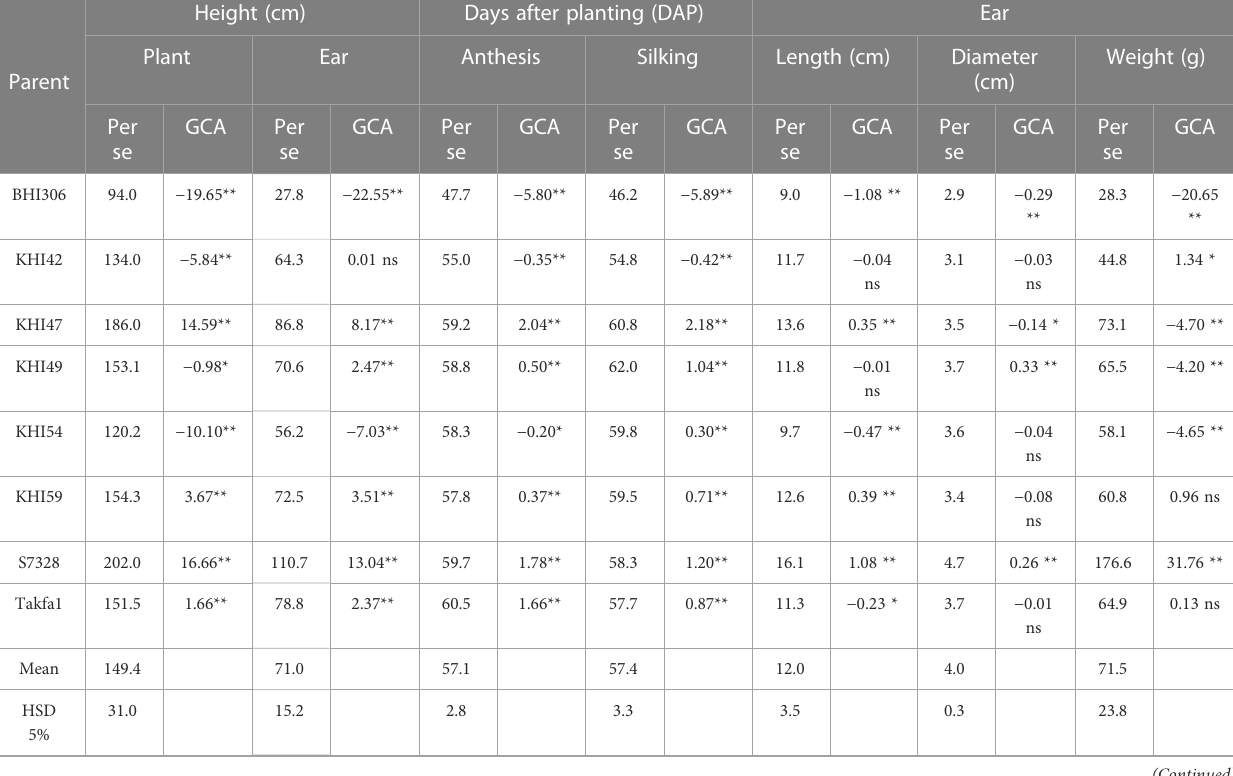
TABLE 4 Estimates of GCA effects and per se performance for agronomic traits, R1-nj seed set, and haploid induction rate of eight parents evaluated in the rainy season of 2021 and the dry season of